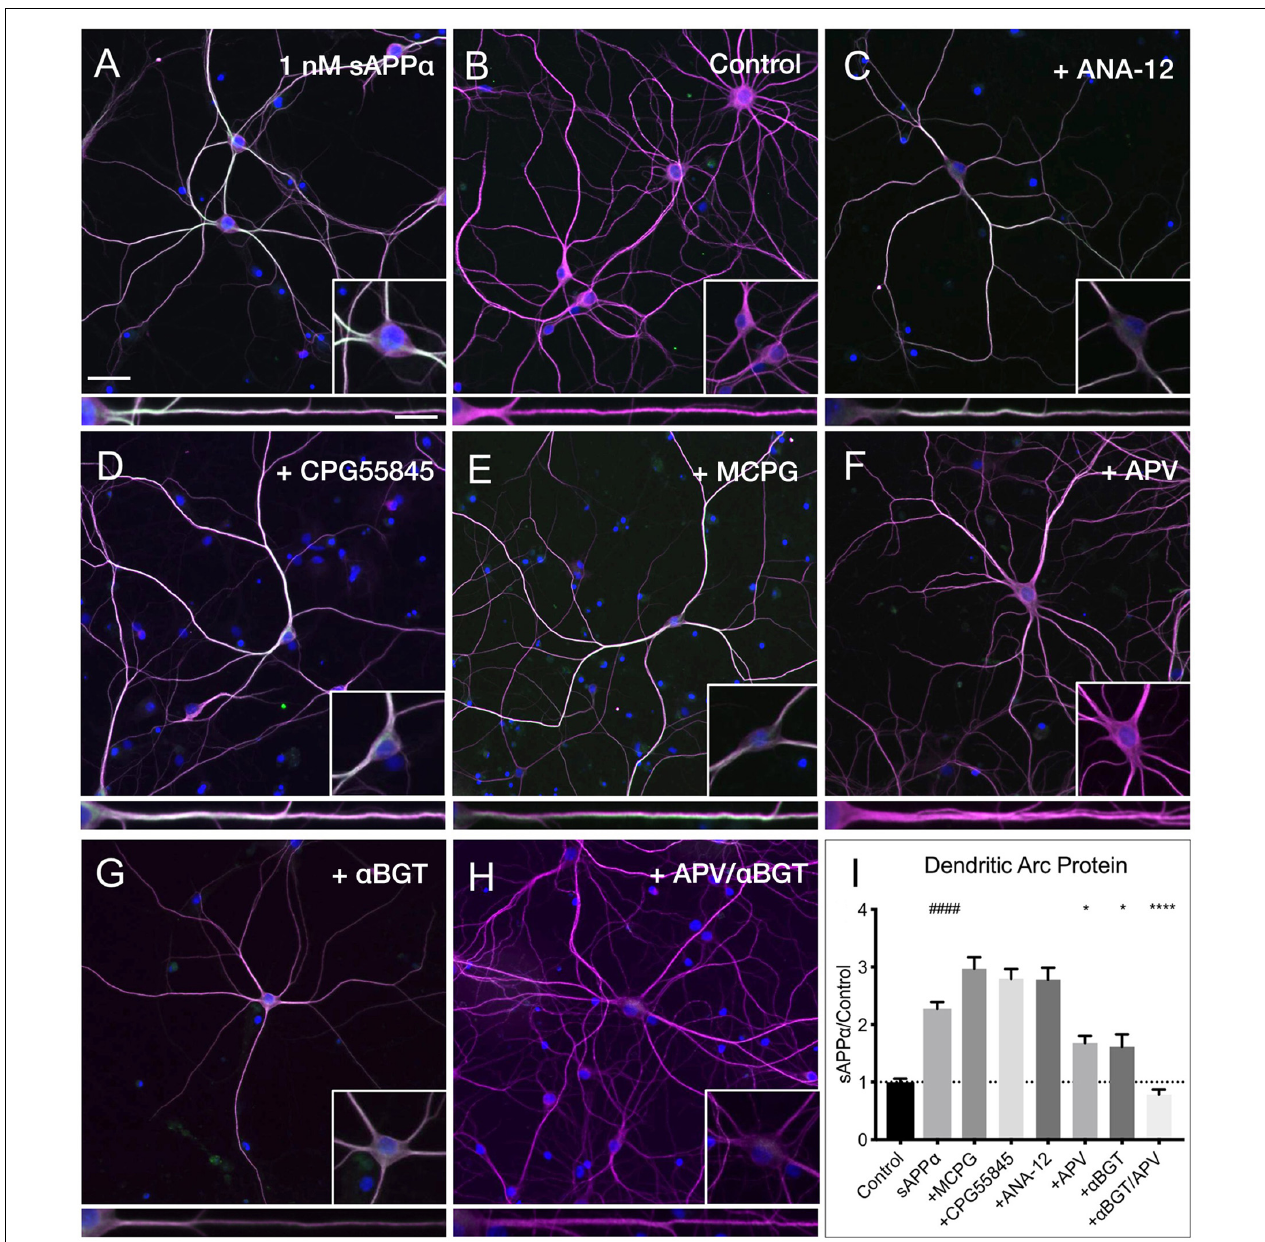
FIGURE 8 | Arc protein expression is dependent on NMDA and α 7nAch receptors. Representative images showing (A) sAPP α (1 nM, 2 h, n = 80) promotes and increase in the expression of Arc protein in cultured hippocampal neurons relative to (B) no drug controls ( n = 80). Co-incubation of sAPP α with (C) ANA-12 ( n = 40), (D) CPG55845 ( n = 40), and (E) MCPG ( n = 40) had no effect on sAPP α -induced Arc expression. Co-incubation with (F) APV ( n = 40), or (G) α BGT ( n = 30) significantly reduced Arc protein expression, while co-incubation with both (H) APV and α BGT ( n = 30) fully eliminated this effect in the (I) dendrites. Outliers were removed from each experiment prior to amalgamation using Grubb’s tests, and normality was detected by D’Agostino and Pearson omnibus normality tests. Data are expressed as mean ± SEM from ≥ 3 experiments. Significance was calculated using a Kruskal–Wallis one-way ANOVA with Dunn’s multiple comparisons test. Hashes (#) indicate significance between control and sAPP α -treated; asterisks ( ∗ ) indicate significance between sAPP α - and antagonist-treated; #### p ≤ 0.0001, ∗ p = 0.0163, ∗∗∗∗ p ≤ 0.0001. Representative images show neurons (magenta), Arc protein (green), DAPI (blue) (scale bar = 50 µ m), and magnified somatic (inset, bottom right) and dendritic (100 µ m; lower panels; scale bar = 10 µ m) compartments.